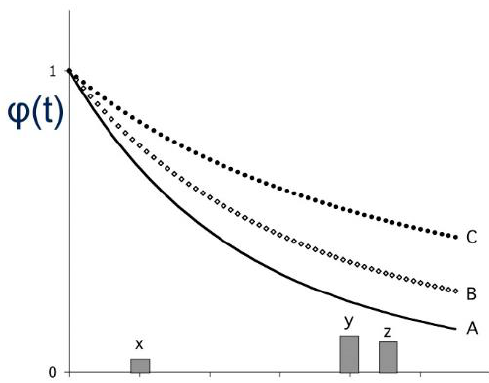
Figure 1. Representation of the two-stage decision problem [37] (p. 10).